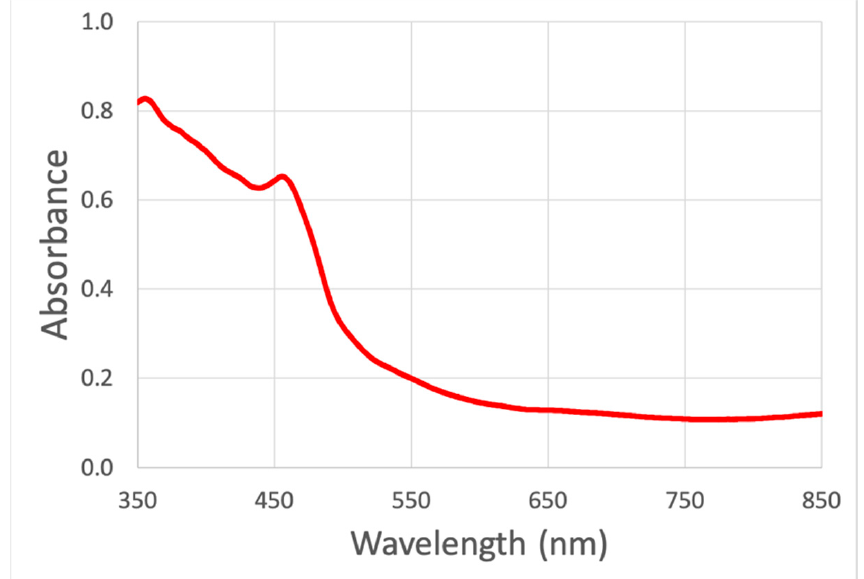
Figure 2. UV/Vis-absorption spectrum of Cu 2 O film deposited using a precursor solution at pH 10, − 0.35 V vs. Ag/AgCl, and 15 min deposition time.